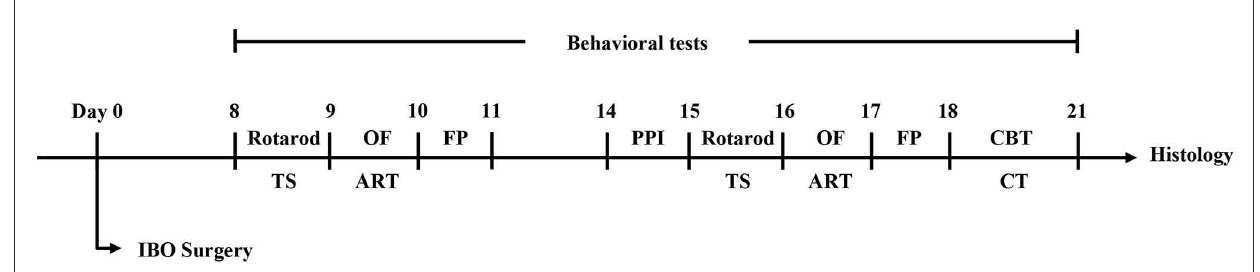
FIGURE1 The flowchart of experimental design. TS, tail suspension test; OF, open field test; ART, adhesive removal test; FP, footprint test; PPI, prepulse inhibition test; CBT, challenge beam test; CT, cylinder